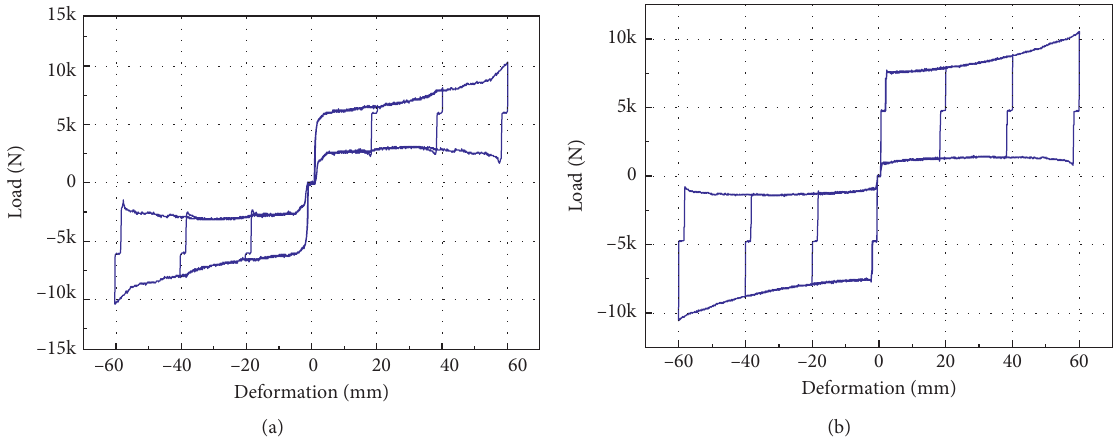
Figure 6: Hysteresis curve under various deformation amplitude (SCVF brace with spring S2). (a) 5mm deflection of the friction plate and (b) 7.5 mm deflection of the friction